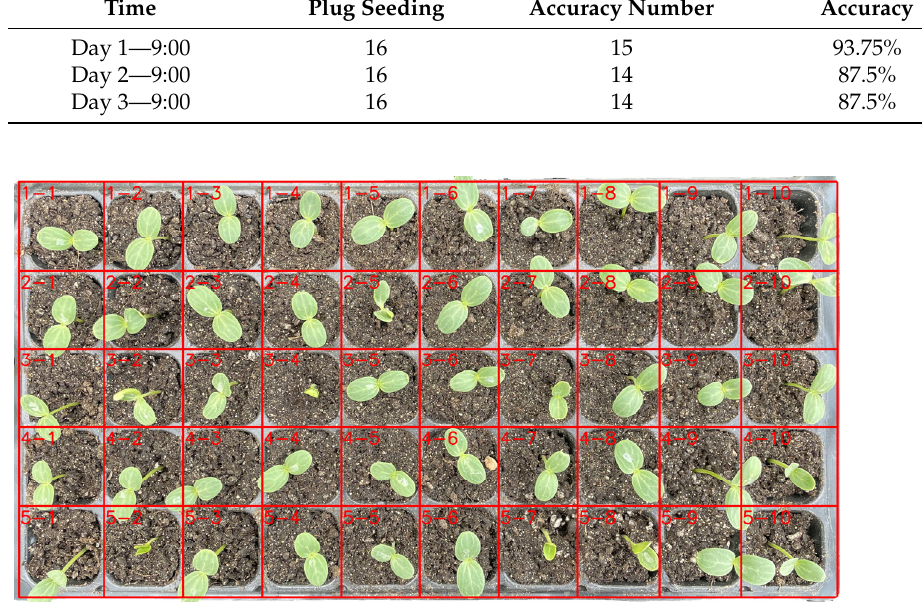
Figure 10. Effect of plug hole positioning for plug seedlings.